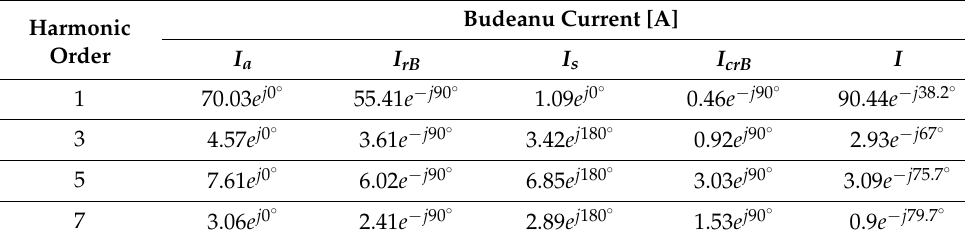
Table 7. List of complex values of currents in developed Budeanu’s theory.